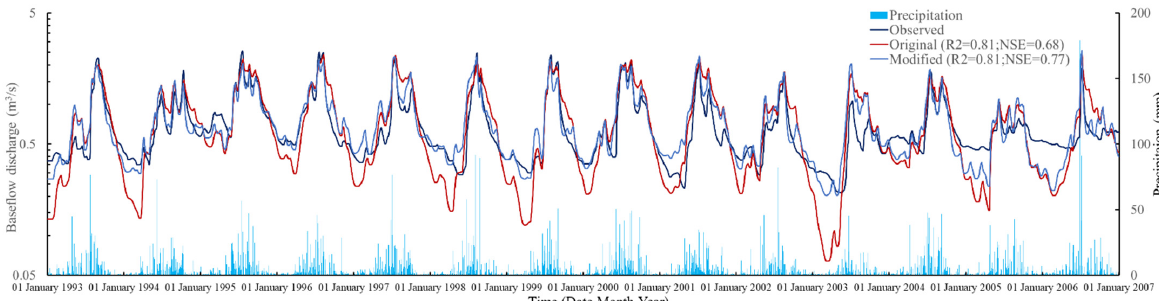
Figure 9. Daily baseflow of the original and modified SWAT models during 1993 to 2006.